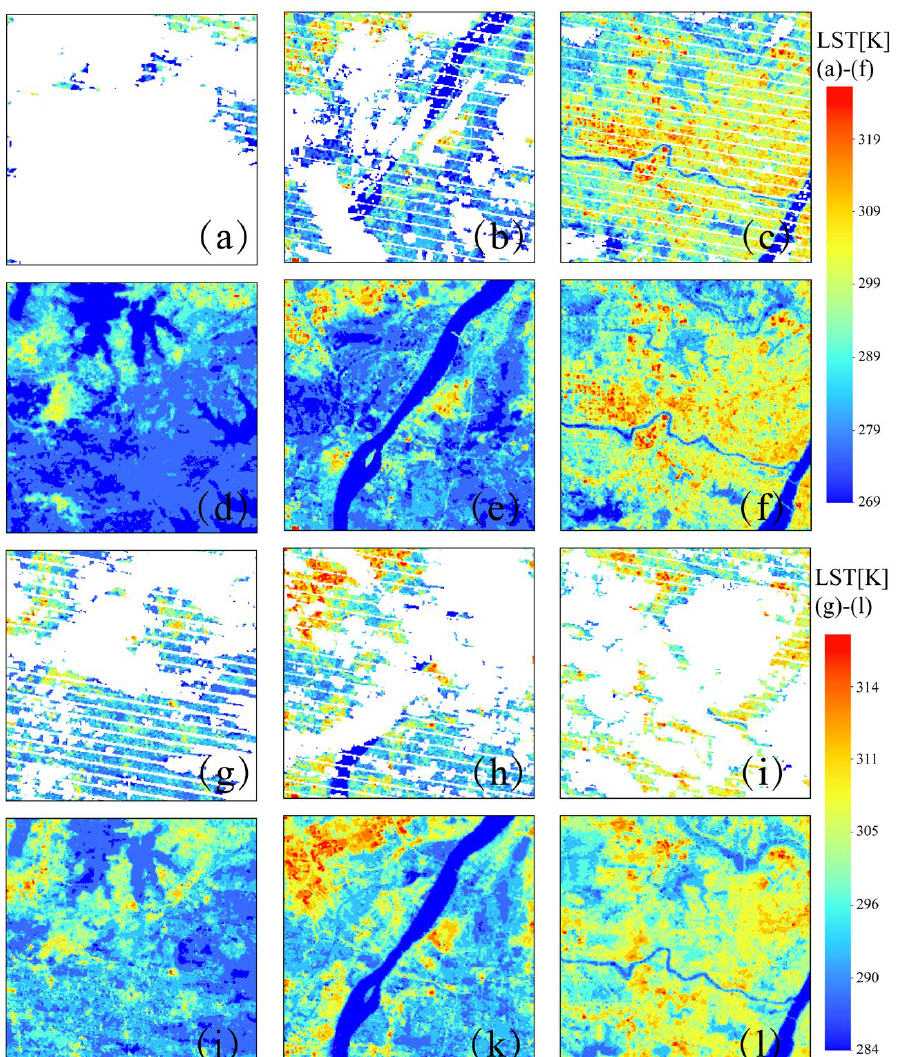
Figure 15. Visual performances of the SFRFR model on 16 June 2017 and 11 August 2020. ( a – c ) Regions with different original LST data on 16 June 2017. ( d – f ) SFRFR predictions for the corresponding regions on 16 June 2017. ( g – i ) Regions that retained different original LST on 11 August 2020. ( j – l ) SFRFR predictions of the corresponding regions on 11 August 2020.